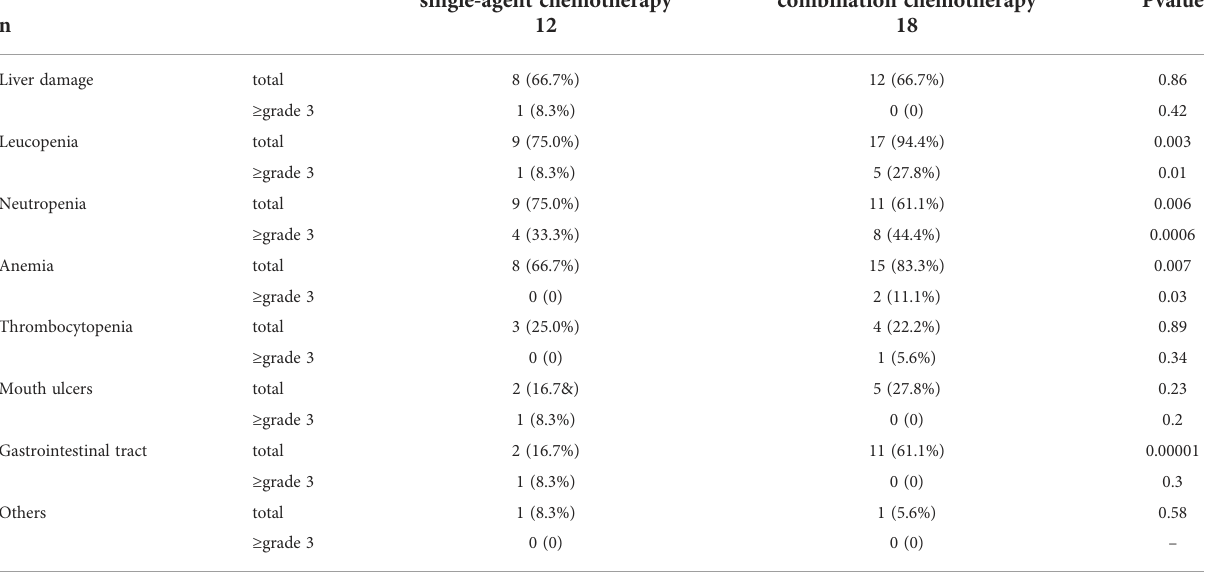
TABLE 3 Adverse reactions.